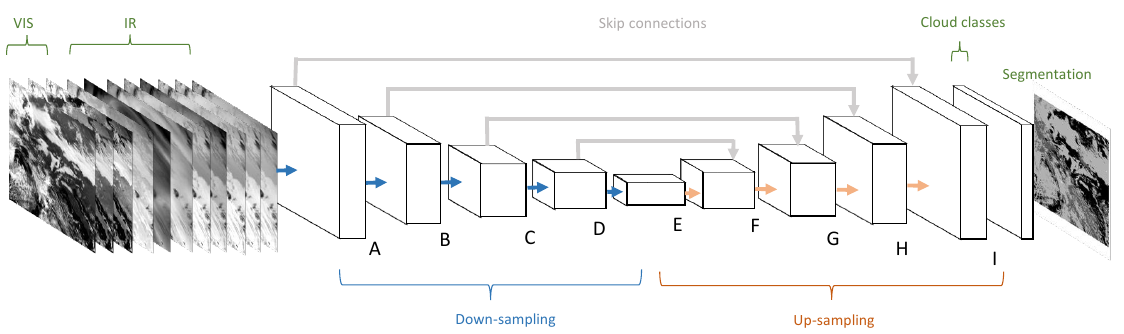
Figure 3. CS-CNN architecture used for cloud